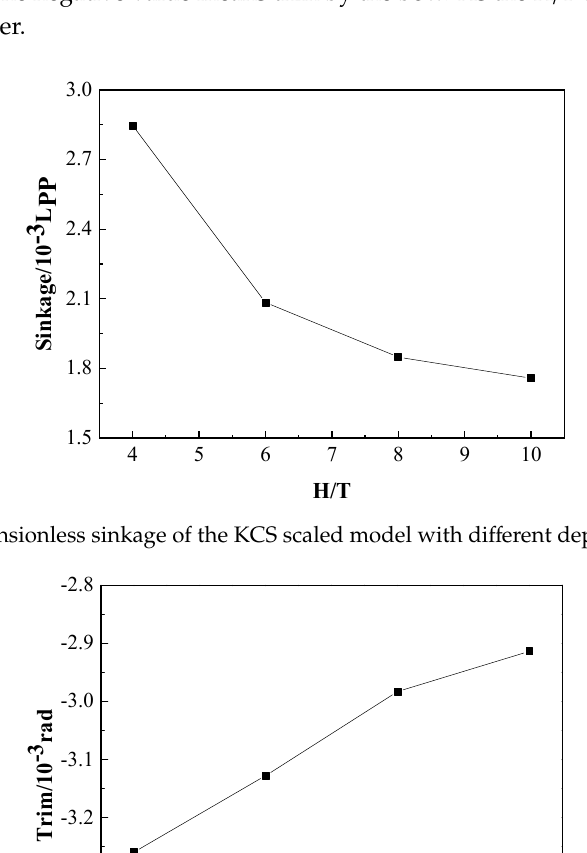
Figure 12. The trim angle with different depth/draft ratios of KCS scaled model (H/T).